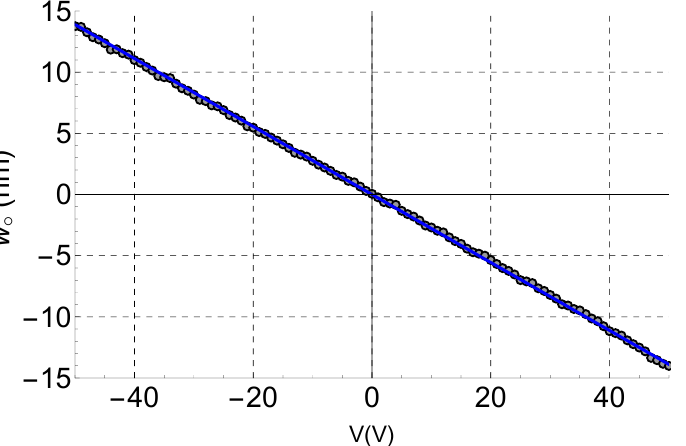
Figure 7. Experimental validation for the proposed technique. Experimental measurements are shown as black circles, and the model prediction line is shown as a solid blue